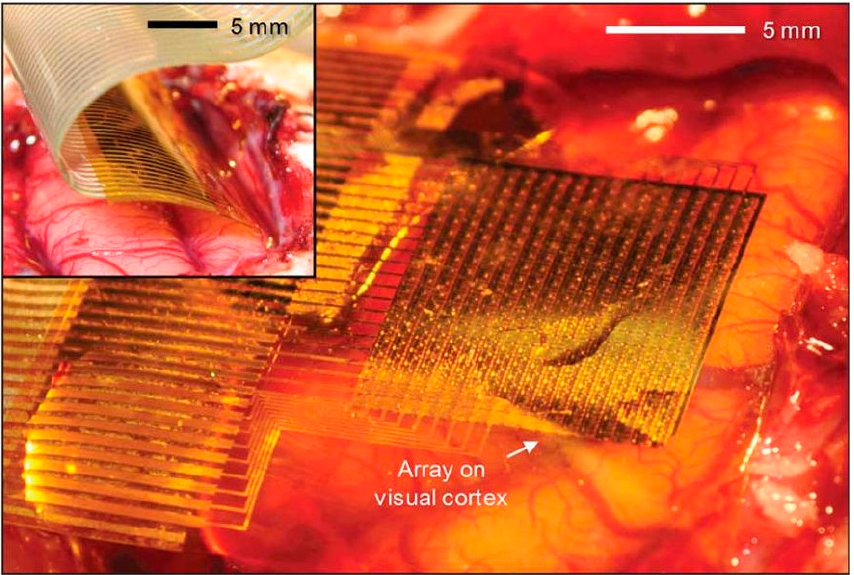
Figure 1. A high-density array of electrodes for mapping neural activity: flexible electrode array insulated and encapsulated by polyimide (unknown trademark) layers placed on the visual cortex of